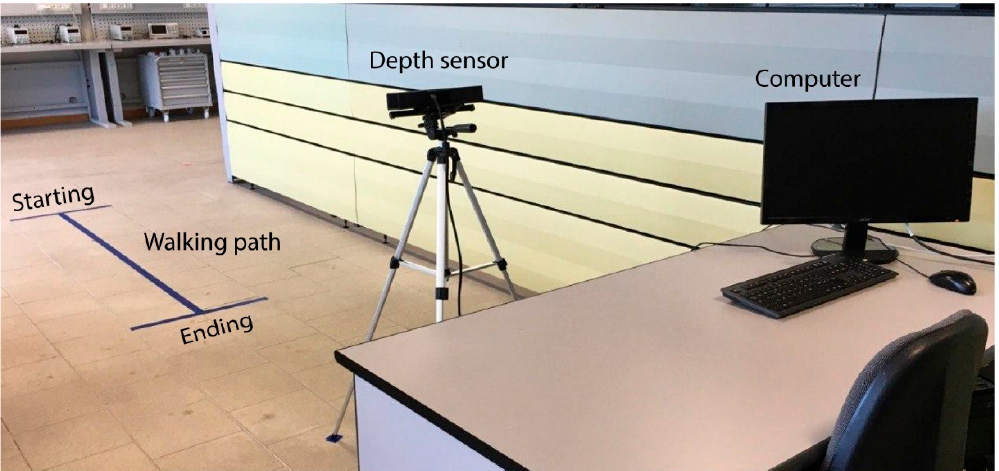
Figure 2. SANE (eaSy gAit aNalysis system) interface: ( a ) overview; ( b ) zoom-Area 1; ( c ) zoom-Area 2; ( d ) zoom-Area 3.